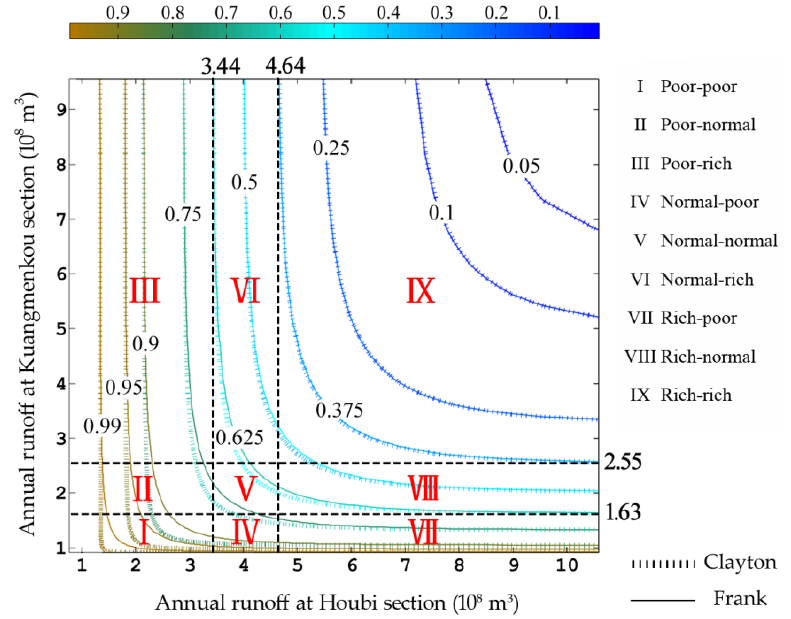
Figure 8. Joint cumulative exceedance probability curves in the cases of Clayton and Frank copulas for annual runoff of tributaries, and synchronous-asynchronous encounter probability of rich-poor annual runoff at Houbi and Kuangmenkou sections (9 districts represent different encounter situations separately, depend on two annual runoff values of each stream at frequencies of 37.5% and 62.5%). Each district amounts to the projected area of cumulative distributions.